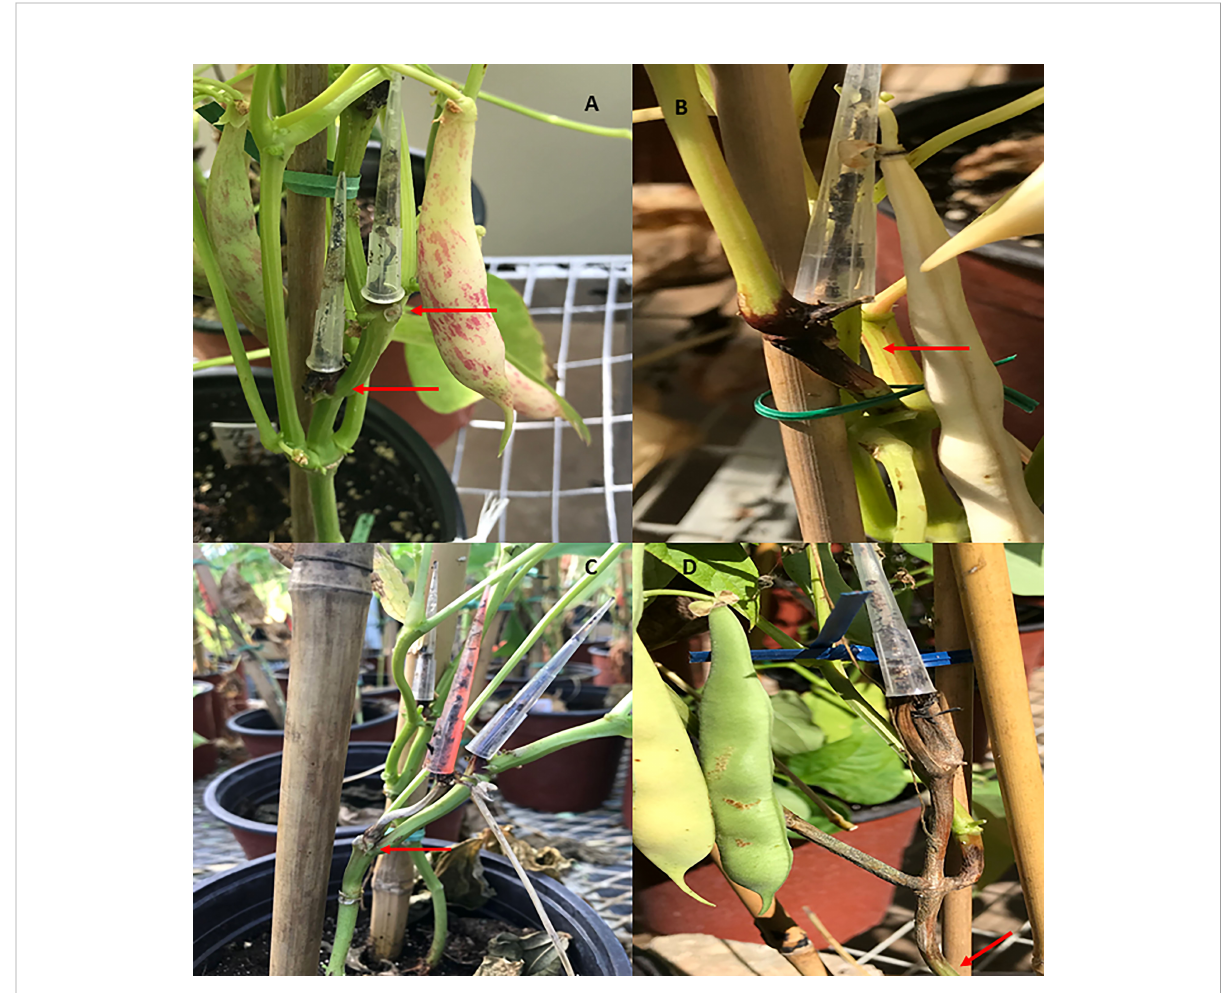
FIGURE 1 The ashy stem blight disease was scored at 42 and 21 days post inoculation in the greenhouse and the fi eld, respectively, using a 1 – 9 scale, where 1 – 3 = resistant, 4 – 6 = intermediate, and 7 – 9 = susceptible. A , score 3; B , score 5; C , score 6; and D , score